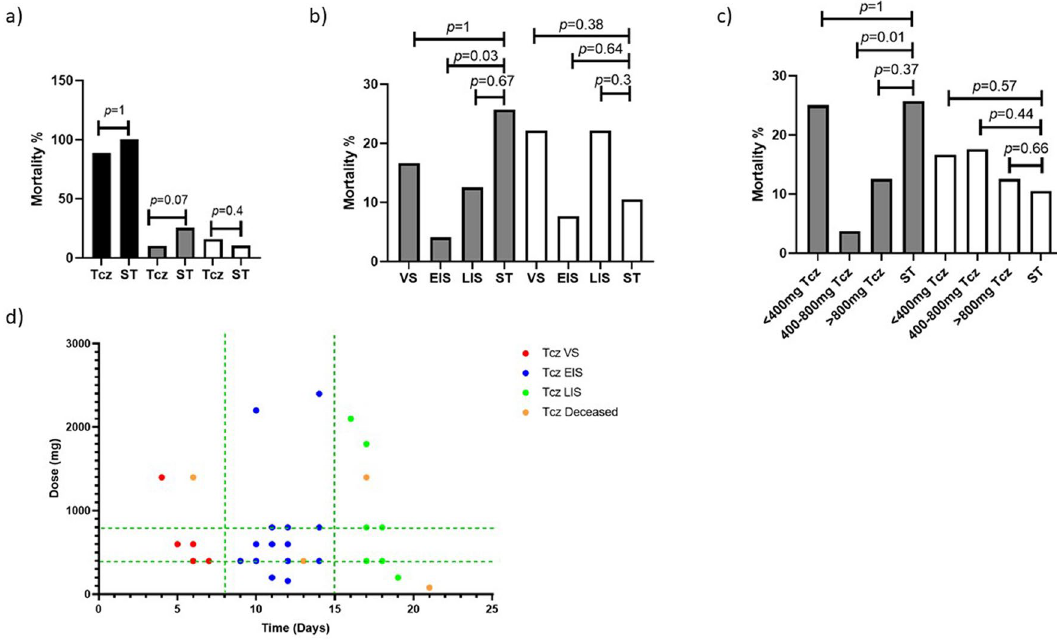
Figure 2. Modulation of mortality by Tocilizumab. Mortality was measured for whole groups of critically (black bars), severely (grey bars) and moderately-ill (white bars) and compared with controls having a similar disease severity ( a ), but severely and moderately-ill patients were further stratified by administration of the drug within different disease stages ( b ) and drug doses used ( c ). Finally, a qualitative multivariate analysis was performed by plotting the severely-ill surviving patients by disease stage and dose used (red, blue and green dots), as well as the severely-ill diseased patients (orange dots) ( d ). Mortality was expressed as percentage and significant differences were measured by a Fisher’s exact test, and considered as such when p ≤ 0.05. Tcz Tocilizumab; ST standard treatment; VS viral stage; EIS early inflammatory stage; LIS late inflammatory stage.